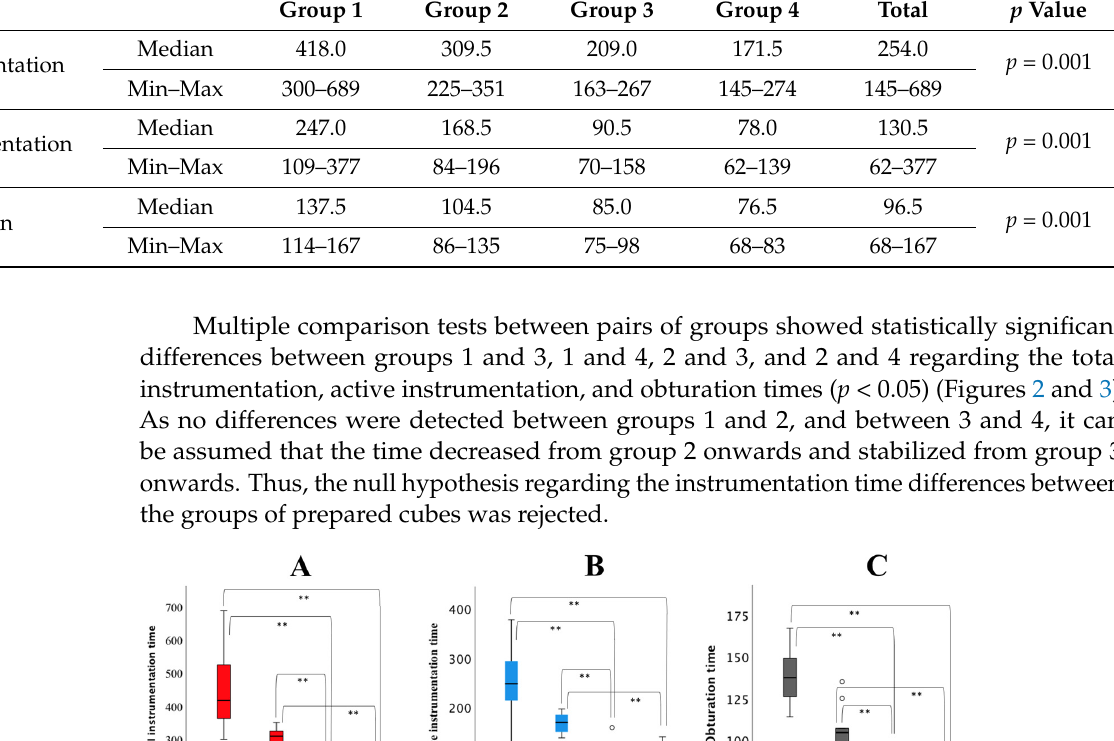
Table 3. Instrumentation and obturation time in seconds (s).